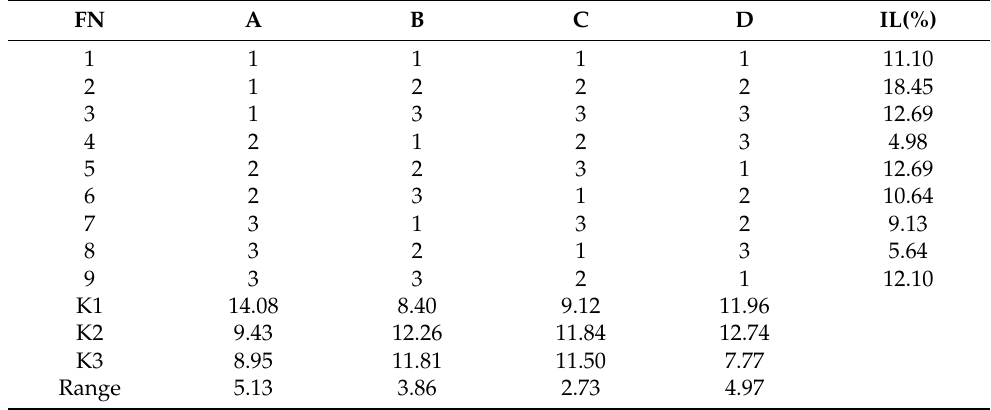
Table 2. Experimental arrangement and results based on the L 9 (3 4 ) orthogonal